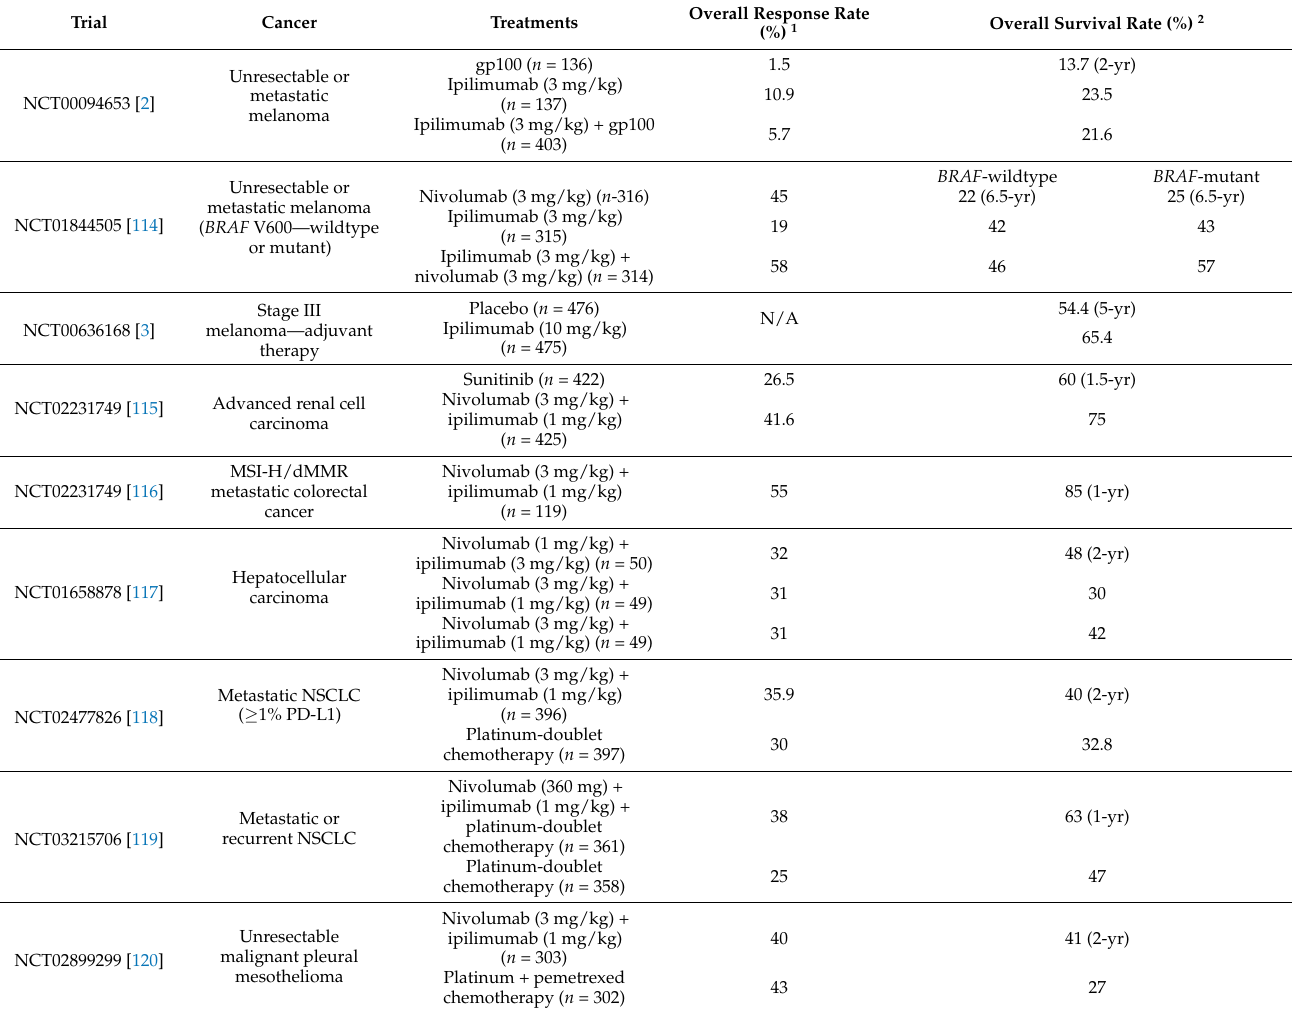
Table 2. Summary of clinical trials for cancers with FDA-approved use of